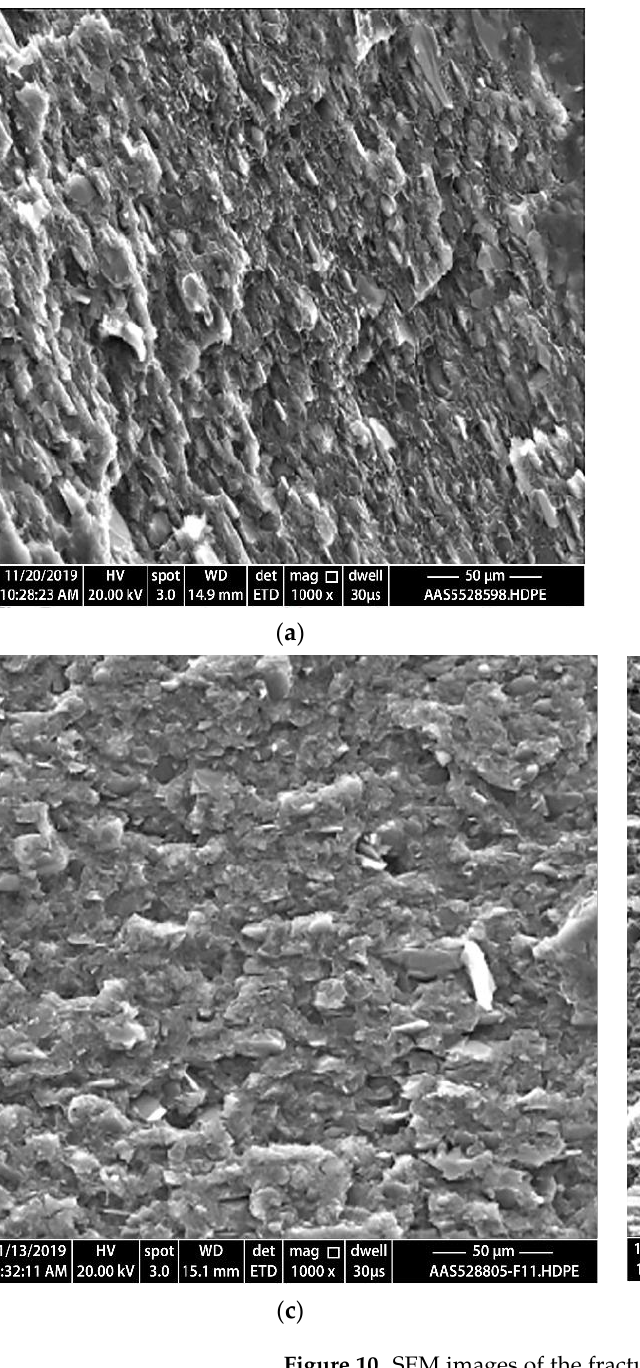
Figure 10. SEM images of the fractured composites (Scale bar is 50 μ m for all images). ( a ) Formulation 2; ( b ) Formulation 7; ( c ) Formulation 11; ( d ) Formulation 16. The images in ( a , c , d ) indicate some clear agglomerations, voids as well as poor dispersion and distribution. While The image in ( b ) exhibit good interfacial adhesion between the fillers and the HDPE polymer matrix com pared to other HDPE/filler composites.